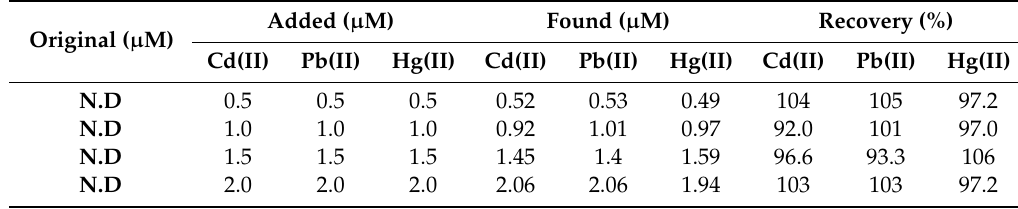
Table 3. Determination of Cd(II), Pb(II) and Hg(II) in tap Table 3 . Determination of Cd(II), Pb(II) and Hg(II) in tap water.